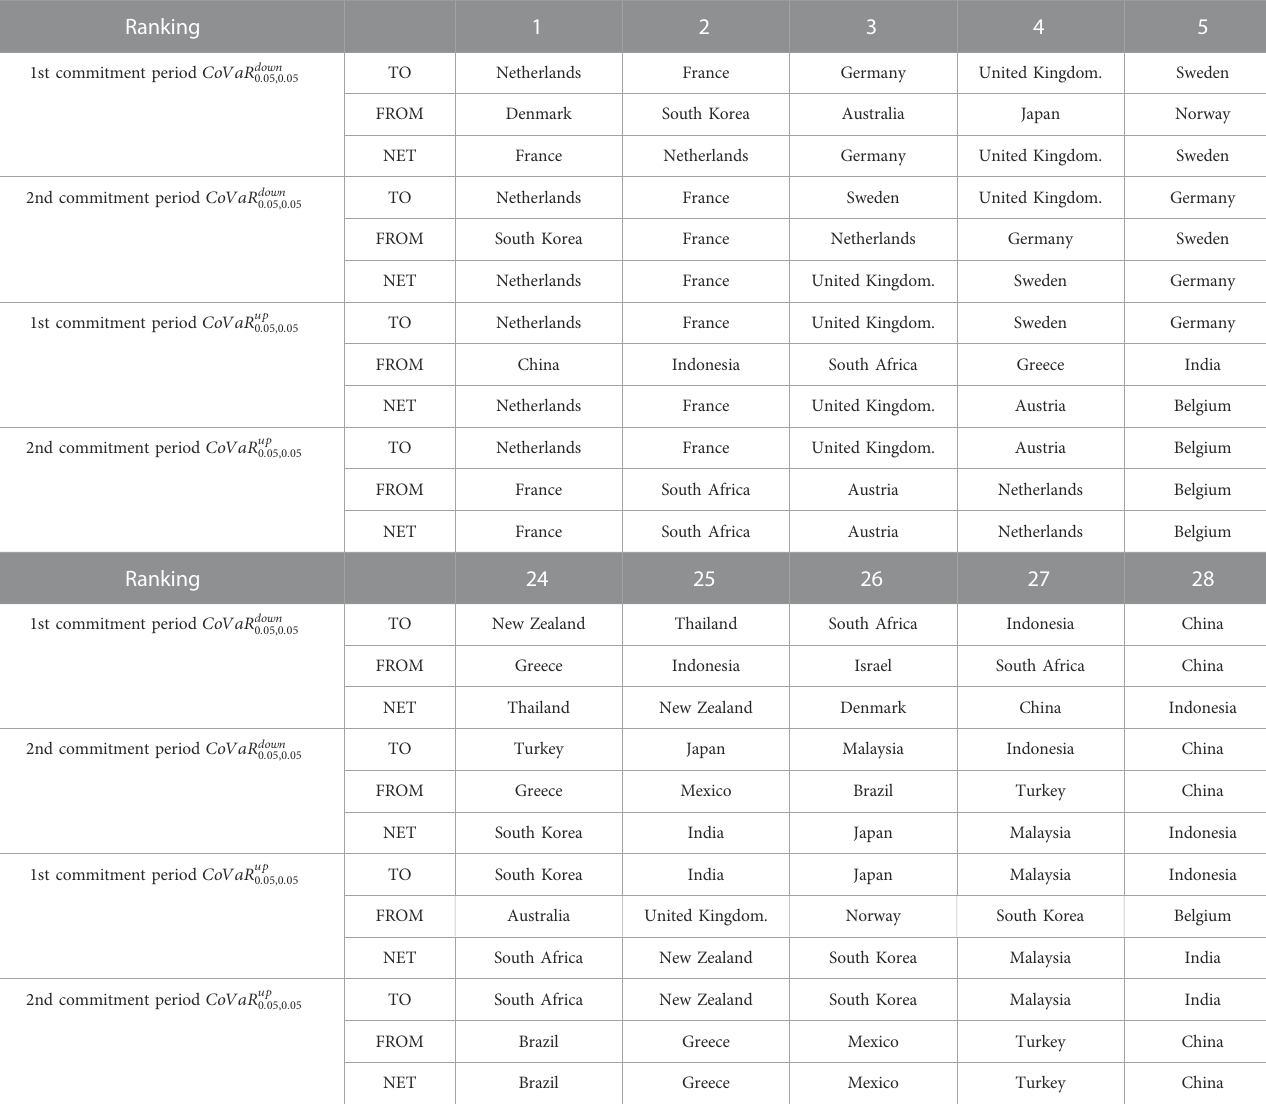
TABLE 6 Static risk spillover effects (top and bottom 5